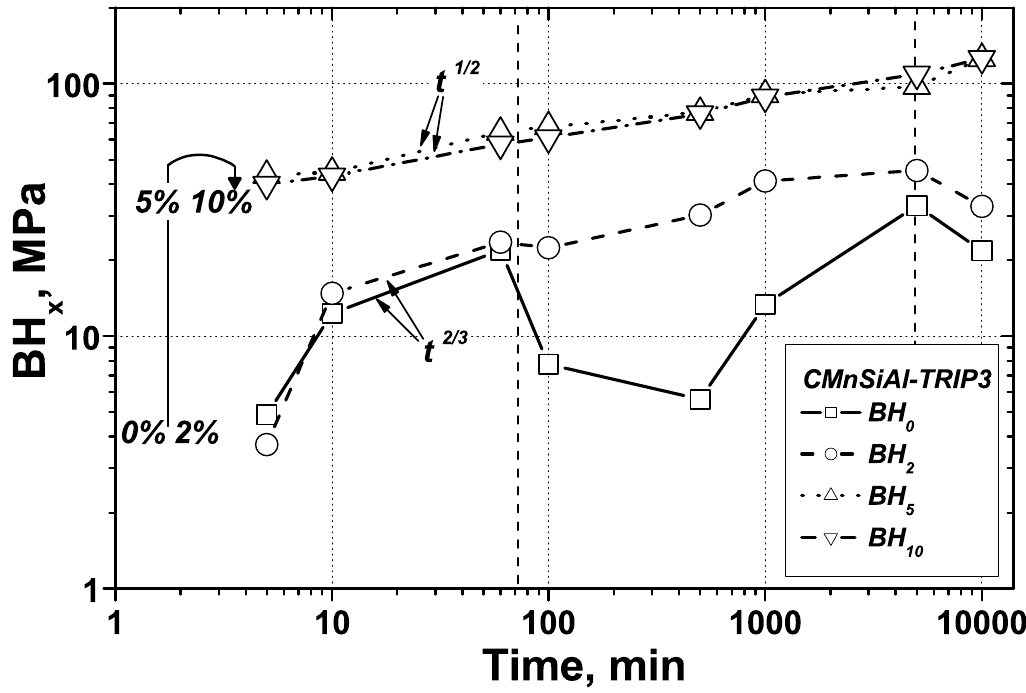
Figure 4. BH kinetics for aging at 170 ◦ C from 5 to 10,000 min for 0%, 2%, 5%, and 5% prestrain for the TRIP3